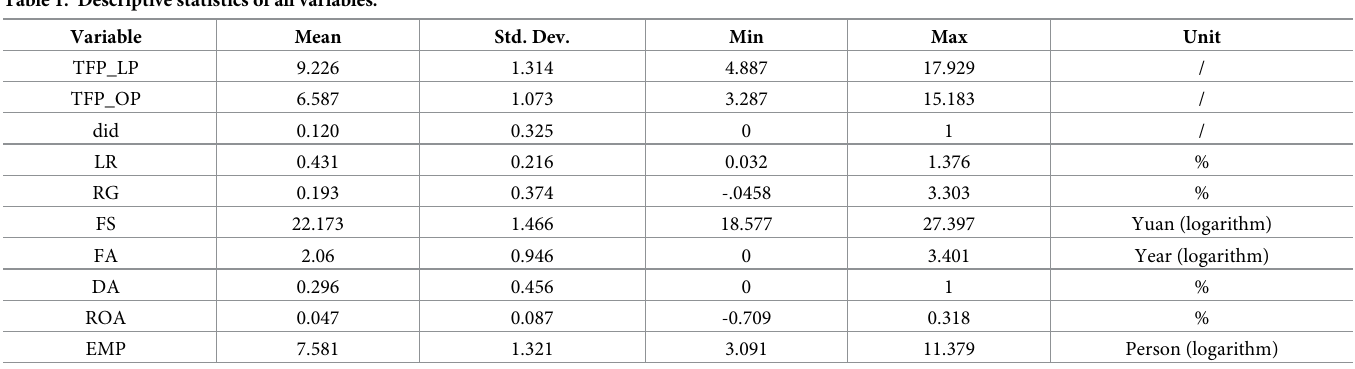
Table 1. Descriptive statistics of all variables.